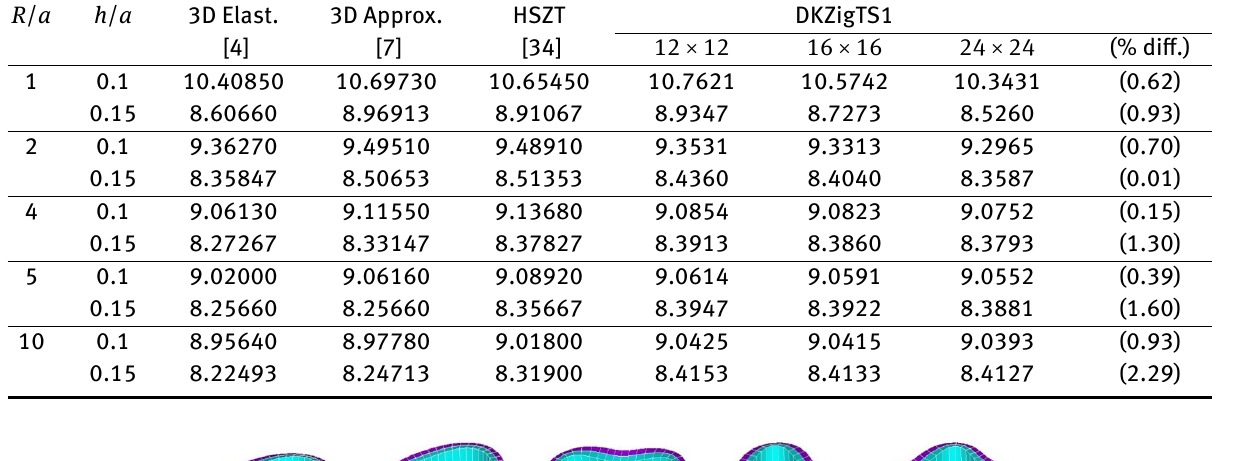
Table 4: Non-dimensionalised natural fundamental frequencies ¯ ω for an all-round simply supported composite cylindrical shell panel ‘B’ with b / a = 1 R / a h / a 3D Elast.